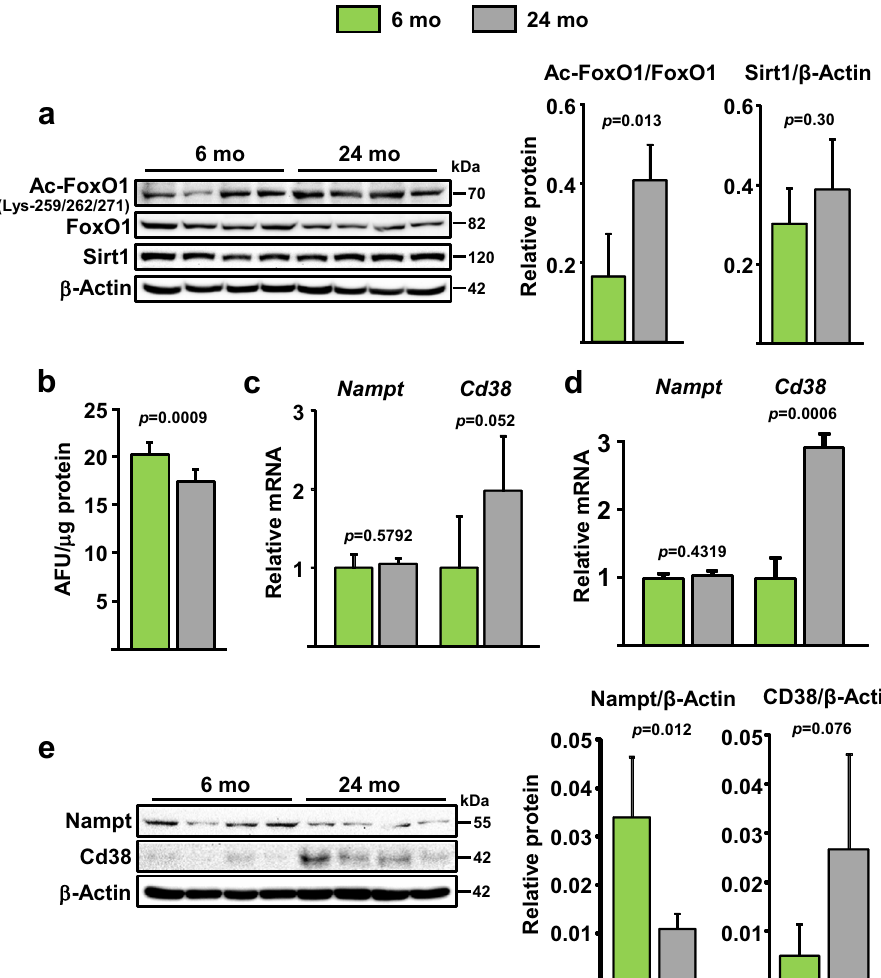
Fig. 1 NAD + declines with age in bone marrow osteoblastic cells. a Protein levels by western blot (left) and relative quanti fi cation (right) of band intensity in bone marrow stromal cells from 6- and 24-month-old C57BL/6 female mice cultured with ascorbic acid and β -glycerophosphate for 5 days; each lane represents one mouse ( n = 4/group). b Relative cellular NAD + levels in cultured osteoblastic cells pooled from 5 mice/group (triplicates of pooled cultures). AFU arbitrary fl uorescence units. c , d mRNA levels by qRT-PCR in ( c ) CD45 − cells freshly isolated from 6- and 24-month-old C57BL/6 female mice ( n = 5/group) and d cultured cells described in a . e Protein levels in cultured stromal cells described in a . Bar graphs represent mean ± SD, data analyzed by Student ’ s t